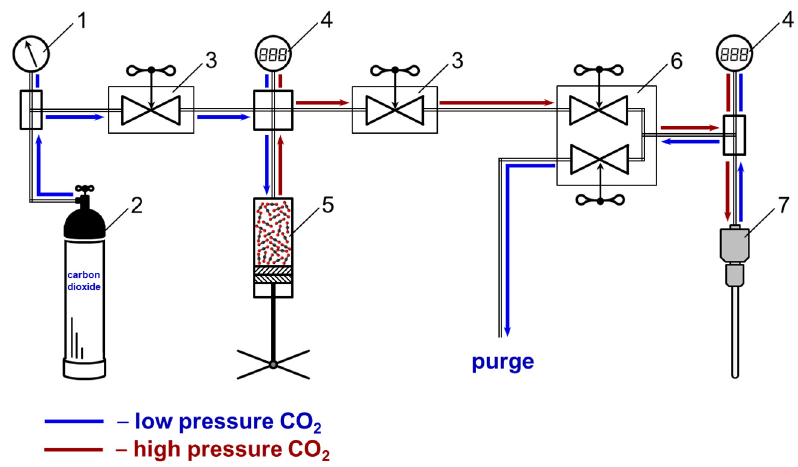
Figure 1. Scheme of the apparatus to produce and maintain pressure for NMR measurements, where 1 is a pressure gauge, 2 is a cylinder with carbon dioxide, 3 and 6 are taper seal valves, 4 are elec- tronic pressure transmitters, 5 is a manually operated syringe pump, and 7 is a high-pressure NMR